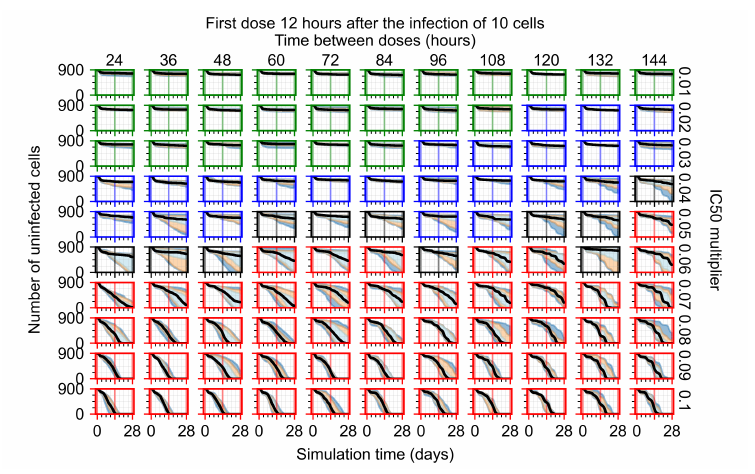
Figure A14. Uninfected population.